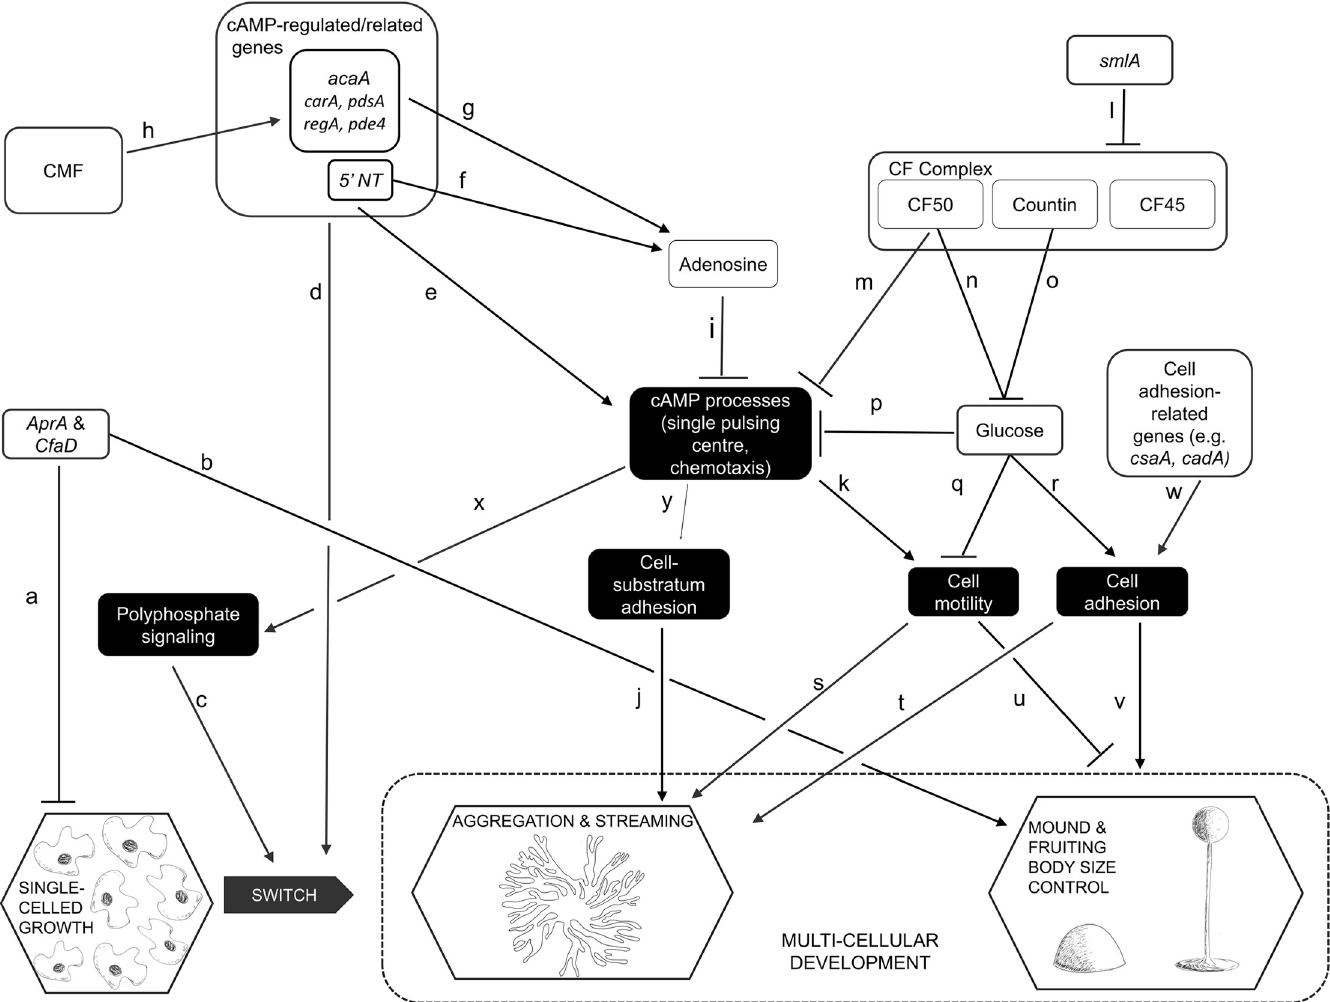
Fig 1. Some of the events, processes and regulators of growth and development in D . discoideum . This figure depicts only a small number of the hypothesized regulatory pathways of Dictyostelium growth and development, focusing on those that were examined experimentally in this study. A line ending in an arrowhead suggests that the first element directly or indirectly promotes the activity or levels of the second; inhibition is suggested by a line ending in a cross-bar. Published works that report on the nature of each pathway within the network are as follows: a[31], [42]; b[31]; c[43]; d[44], [45], [46]; e[47], [48], [49], [50]; f[51]; g [52], [53]; h[54–56]; i [57], [35]; j[58]; k[59], [60], [61]; l[28], [41]; m[29]; n[37]; o[62], [63]; p[64]; q[64], [65]; r[64]; s[66]; t[65]; u[67]; v[68], [41]; w[69], [70]; x[43]; y[71].